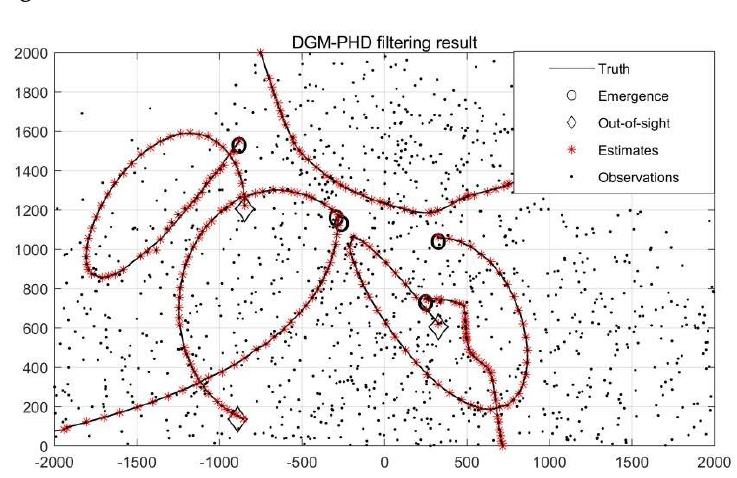
Figure 5. DGM − PHD filter results.